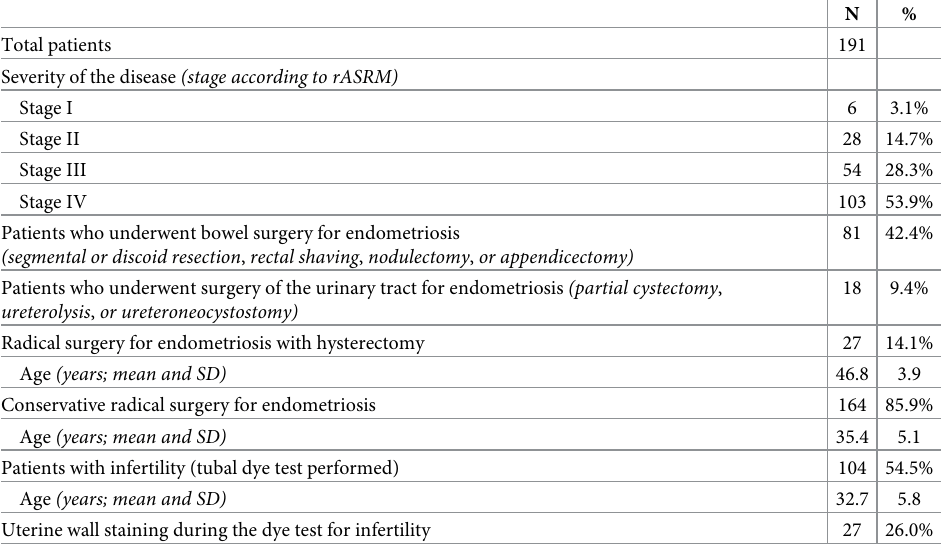
Table 1. Patients who underwent laparoscopy for endometriosis in the study period.